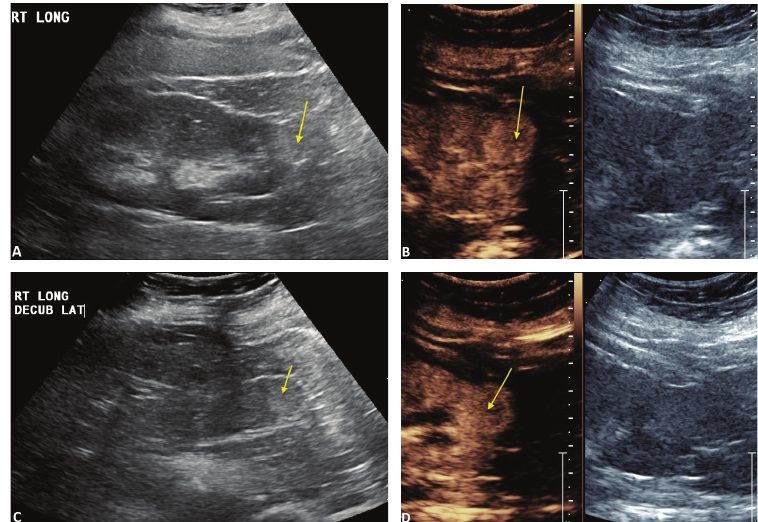
Figure 5. Failed ablation. Patient has history of prior left nephrectomy for RCC and presented with right renal mass. (A) Gray scale image of mass (arrow) pre-ablation. (B) CEUS demonstrating increased flow in tumor (arrow) at inferior pole of right kidney. (C) Gray scale image post-RFA of the mass (arrow). (D) CEUS post-RFA demonstrating flow throughout the tumor (arrow), indicating failed RFA.